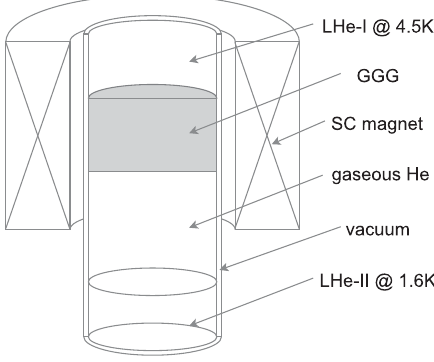
FIG. 3. GGG entropy calculated with free ion model depending on magnetic field B and temperature T . FIG. 4. Scheme of the Hitachi static magnetic